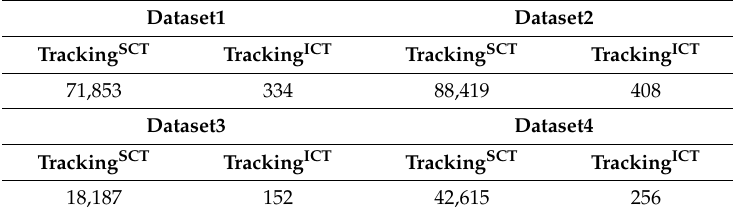
Table 1. Ground truth for all four sub-datasets.